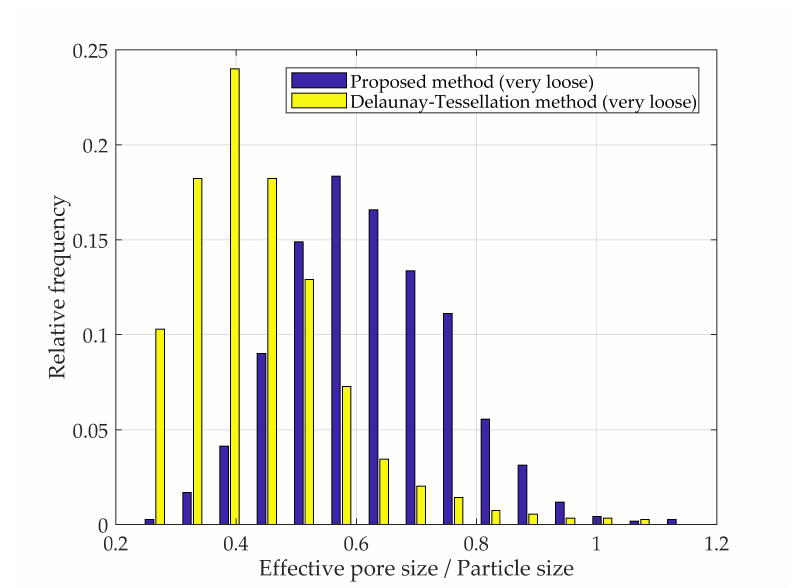
Figure 9. PSD according to the Delaunay tessellation and proposed methods in a very loose mono-sized packed spheres.